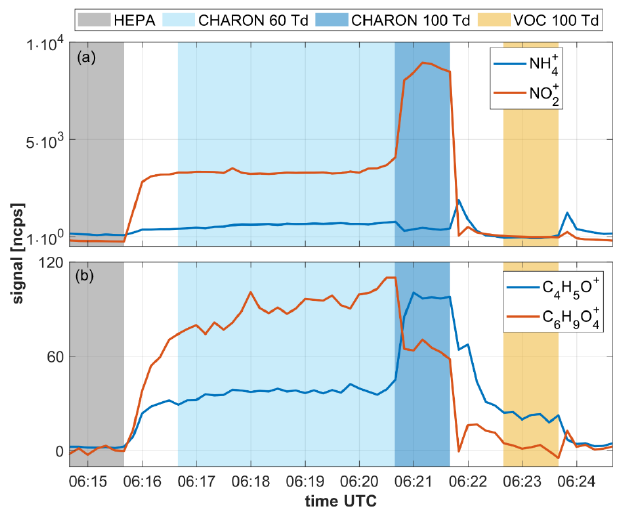
Figure 7. Time series showing various analyte signals as recorded during a 10min measurement cycle of ambient air. The 10min measurement cycle included (i) 1min of instrumental background measurements with the CHARON inlet including a HEPA fil- ter, (ii) 4min of particulate measurements at an E/N of 60Td, (iii) 1min of particulate measurements at an E/N of 100Td and (iv) 1min of gas measurements at an E/N of 100Td. The benefit of measuring particles at 60 and 100Td is explained in Leglise et al. (2019) and is not discussed here. The CHARON inlet enriched the particle concentration by a factor of ∼ 20, which explains the higher signal intensities in the particle measurement (in blue) as compared to the gas measurement (in yellow).